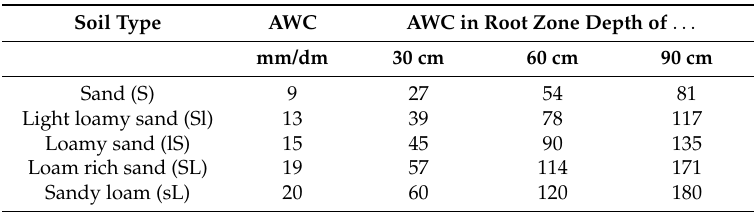
Table 3. Available water content (AWC) in 30, 60 and 90 cm soil zone depth for representative soil types in Hessian Reed